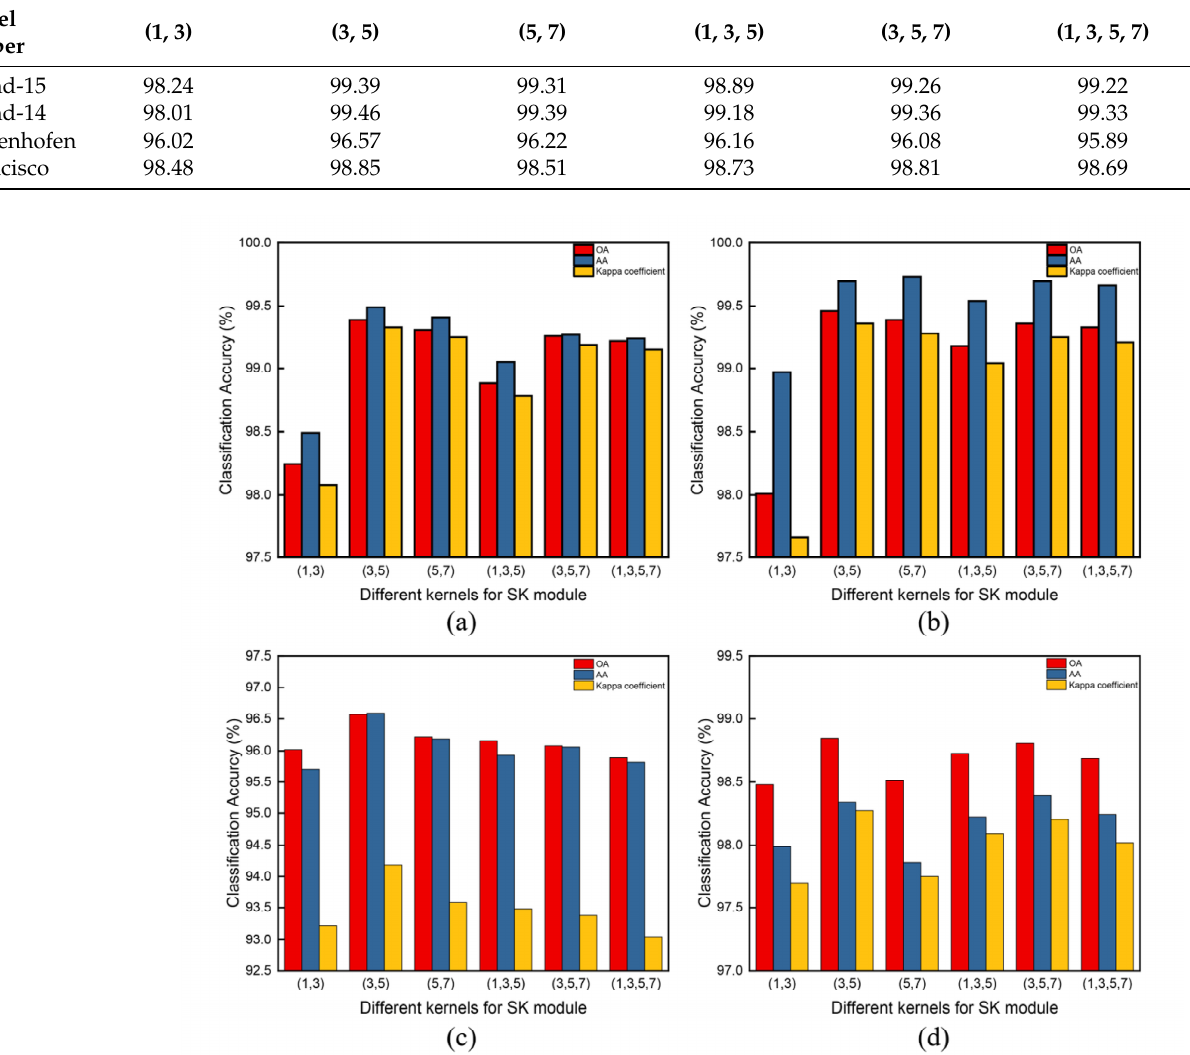
Table 11. Performance contribution of different kernels in the SK module.